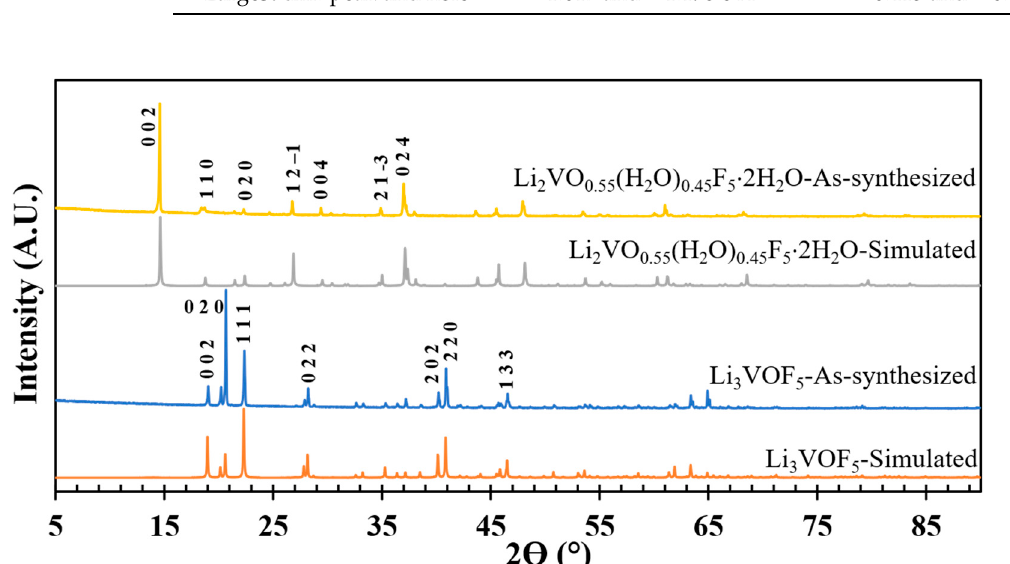
Figure 1. Observed and simulated powder X-ray diffraction patterns of Li 2 VO 0.55 (H 2 O) 0.45 F 5 ⋅ 2H 2 O (I) and Li 3 VOF 5 (II) .